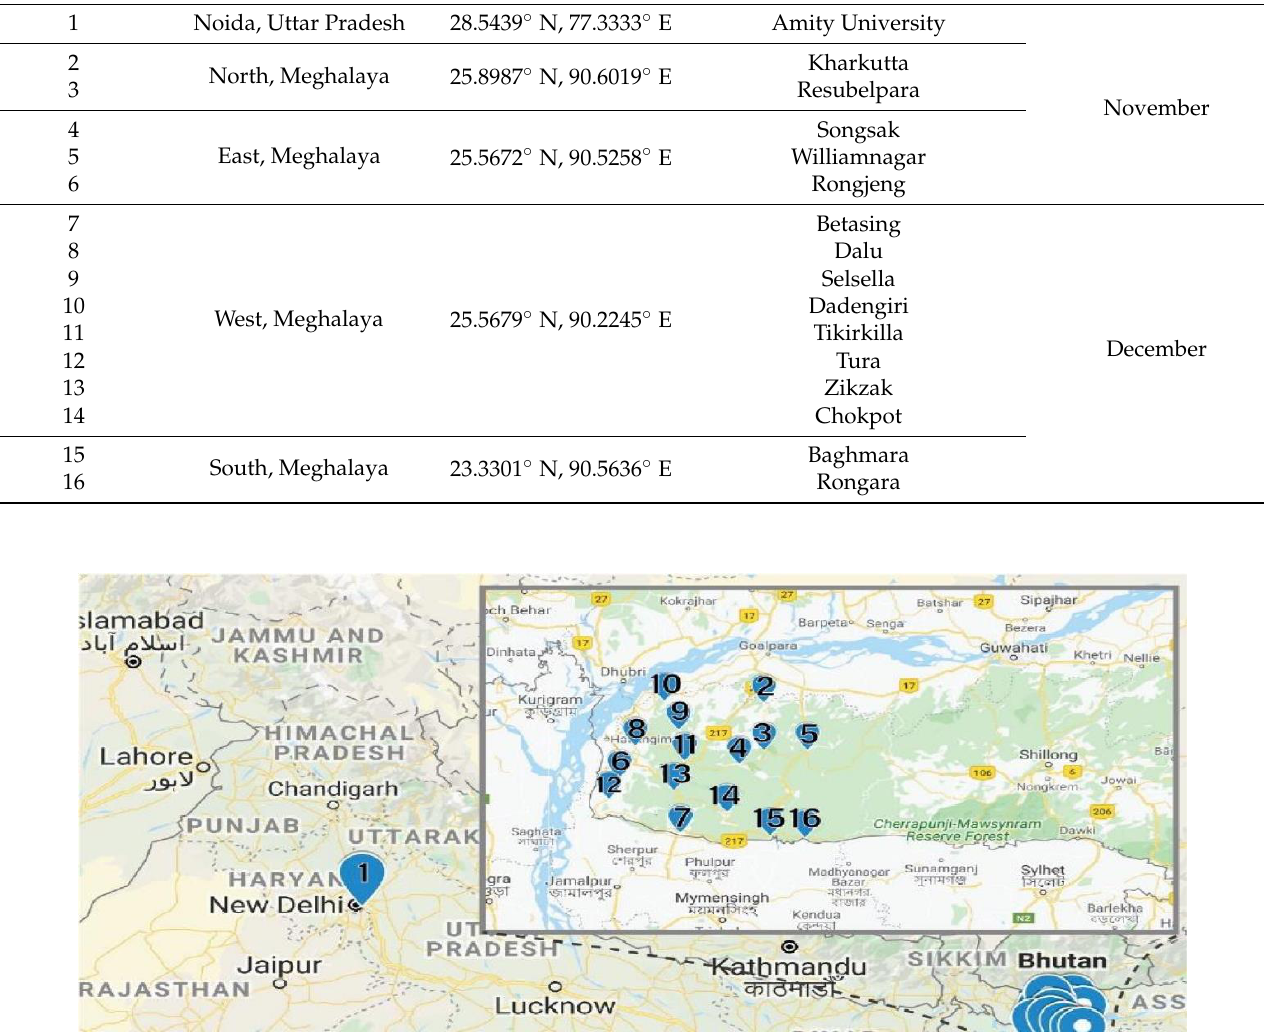
Table 5. Locations of H. sabdariffa calyces sample collection.